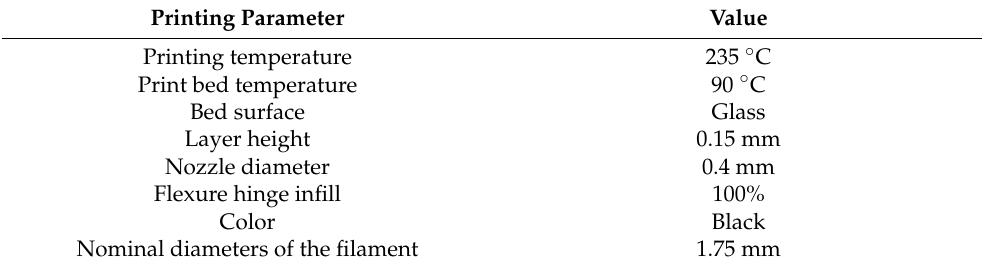
Table 2. Parameters used for 3D-printed Taulman Nylon